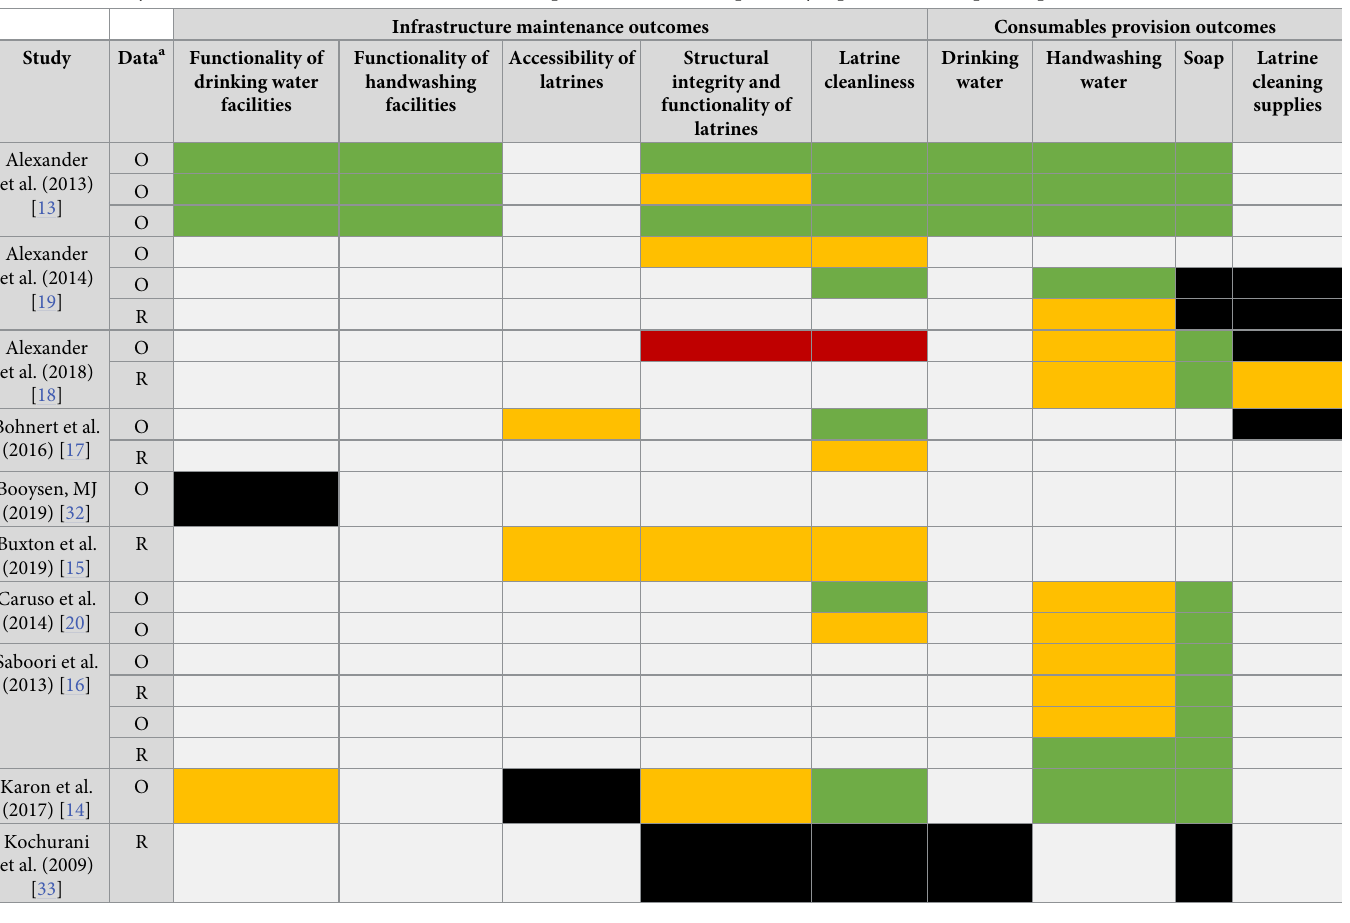
Table 3. Summary of infrastructure maintenance and consumables provision outcomes reported by experimental and quasi-experimental